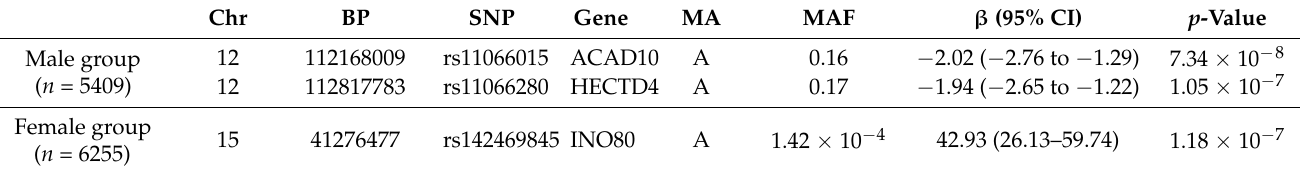
Table 3. Sex-stratified EWAS results of systolic blood